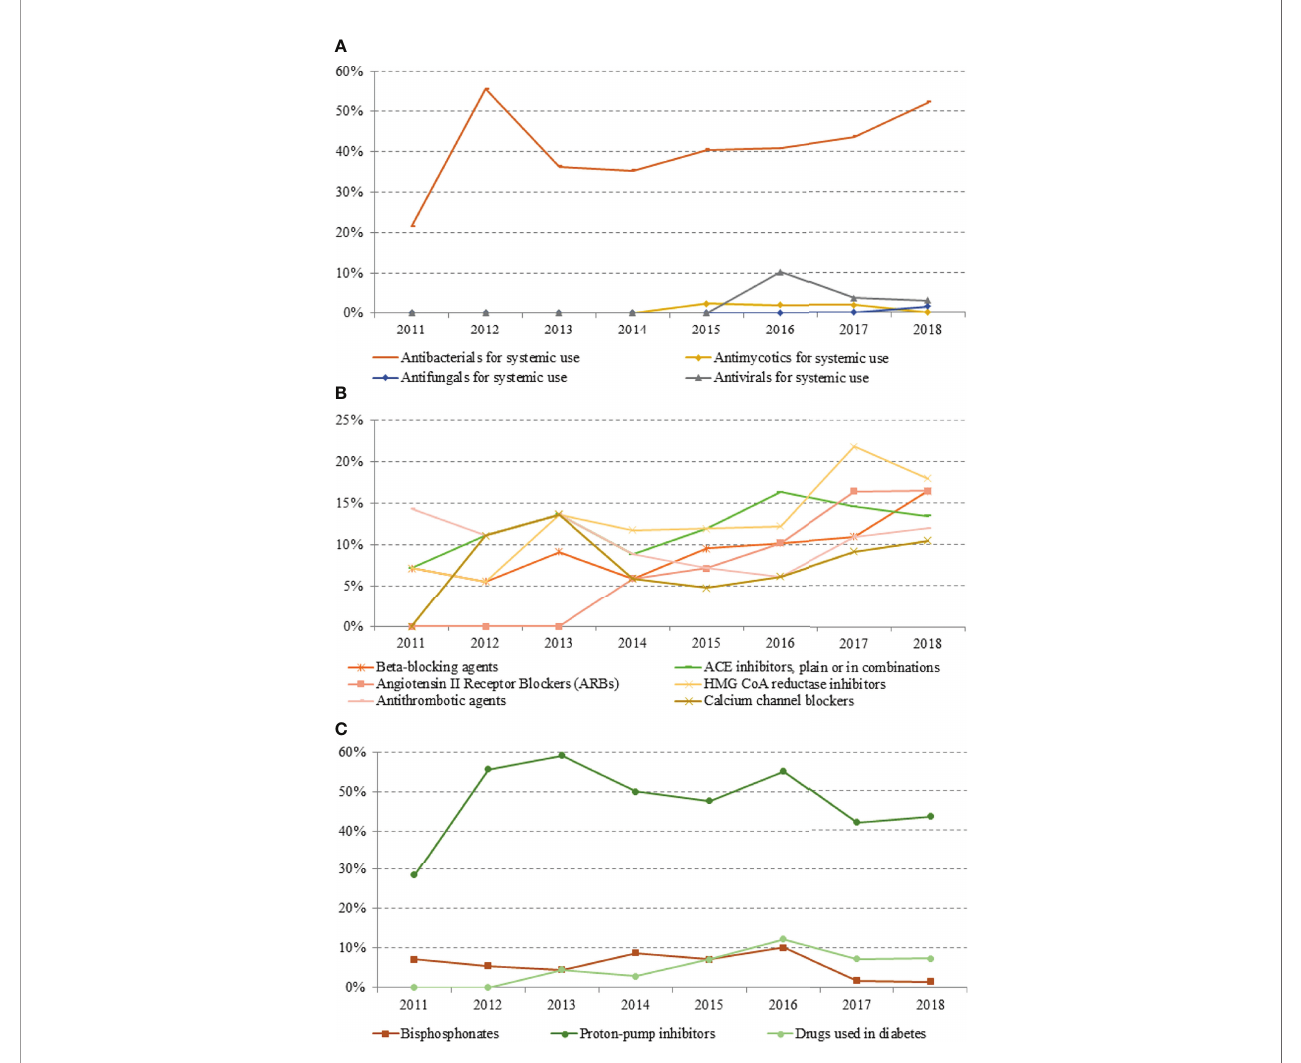
FIGURE 4 | Prevalence trend (2011 – 2018) of therapies for the management of pemphigus-associated comorbidities: (A) antibacterial, antimycotics, antifungals and antivirals for systemic use; (B) beta-blockers, angiotensin II receptor blockers, ACE inhibitors, antithrombotic agents, HMG CoA reductase inhibitors, and calcium channel blockers; (C) bisphosphonates, proton-pomp inhibitors, and antidiabetic